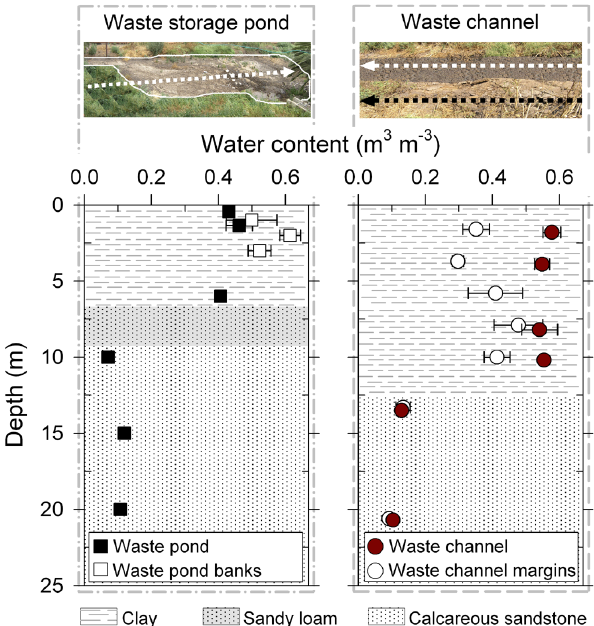
Fig. 1. Water content profiles under the waste channel and its mar- gins and under the waste storage pond and its banks. Results are presented as averages, and the horizontal bars are the standard de- viation between all the measurements (2007–2011) made by each FDTR